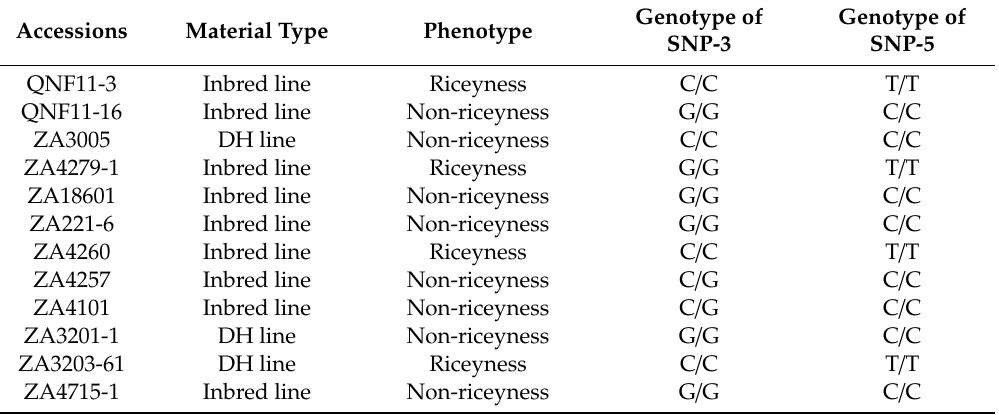
Figure 4. Identification of CC and TT genotype in parents and other breeding lines. Red arrows indicate the position of SNP-5. Table 4. Allelic variation of SNP-5 among cauliflower breeding lines detected in the present